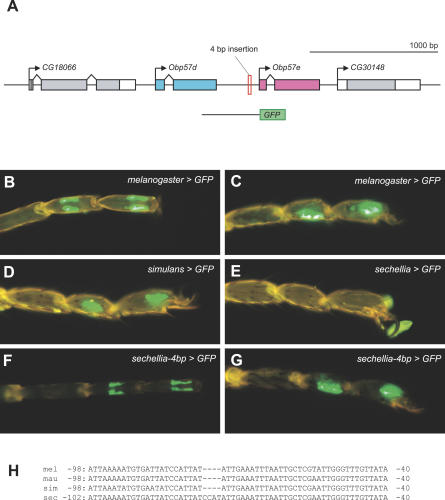

GFP Reporter Assay of Obp57e
(A) Genomic structure around the Obp57e gene. Positions of the region used for the GFP reporter construct and 4-bp insertion in D. sechellia are indicated. Arrows on Obp57d and Obp57e indicate the position of the predicted translation-start sites (ATG), not that of the transcription start sites, which are unknown for these genes.(B–G) GFP reporter expression in tarsi. GFP driven by D. melanogaster Obp57e upstream sequence. (B) Dorsal view and (C) lateral view. GFP driven by (D) D. simulans and (E) D. sechellia Obp57e upstream sequence. (F and G) Removal of CCAT insertion from the sechellia > GFP construct restored GFP expression. (F) Dorsal view and (G) lateral view.(H) D. sechellia-specific 4-bp insertion in the upstream regions of Obp57e. Sequences from D. melanogaster (mel), D. simulans (sim), D. mauritiana (mau), and D. sechellia (sec) are aligned. Numbers indicate positions relative to the translation start site (ATG).